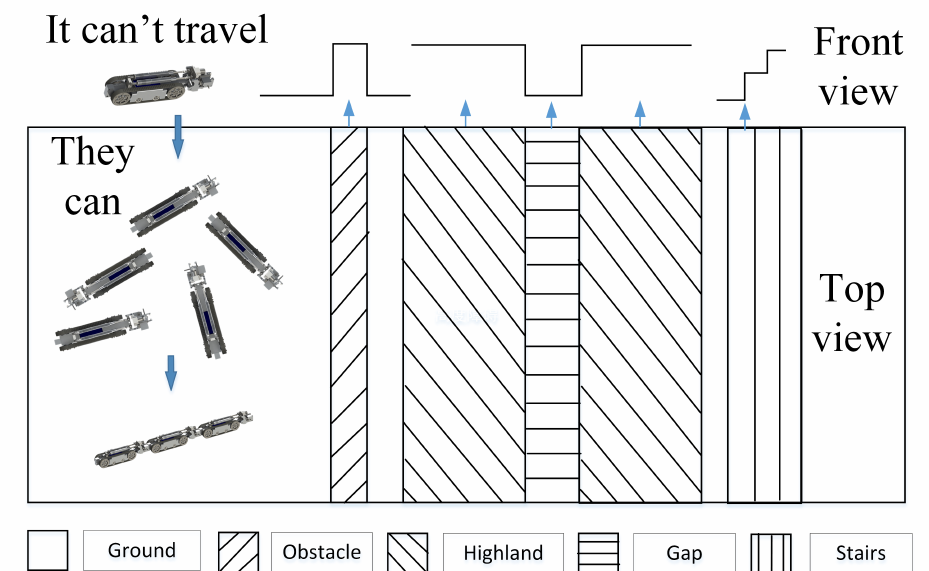
Figure 1. Limited capacity of individual robots and enhanced capacity of self-assembling mobile modular robots by mechanically connecting their modules together. In the front view, it can be seen that there are different terrains such as the ground, obstacles, highland, gaps, and stairs blocking single modular robots, whereas these modular robots can assemble into an articular structure to overcome these difficulties, as shown in the top